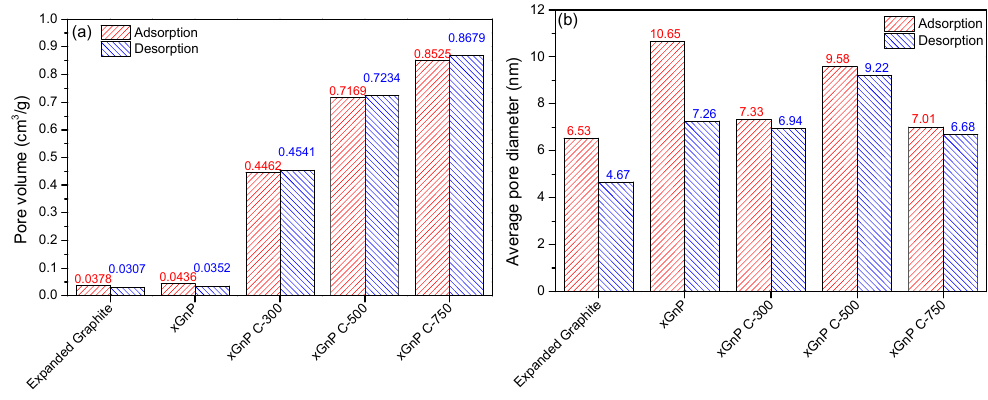
Figure 5. Adsorption and desorption properties of porous carbon materials of N 2 at 77K: ( a ) pore volume and ( b ) average pore diameter.